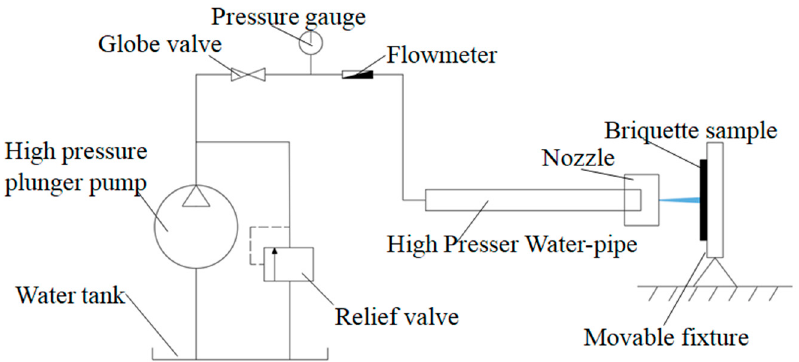
Figure 12. Schematic diagram of equipment.